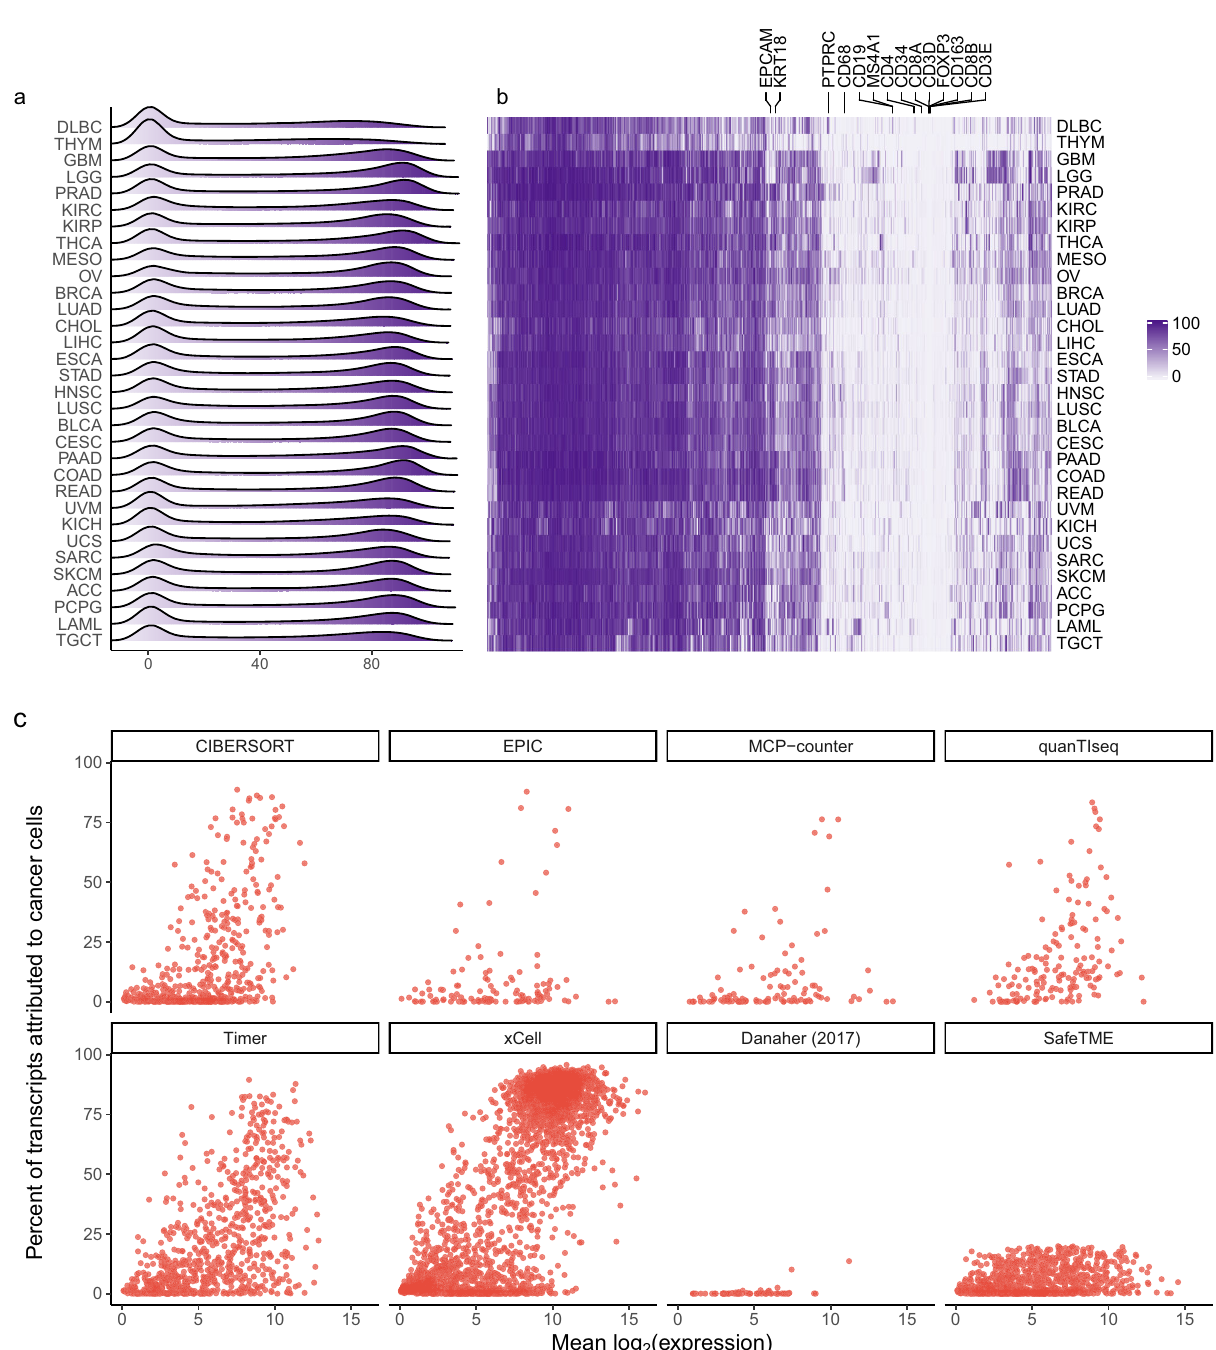
Fig. 3 Genes ’ proportions of cancer cell-derived expression in tumors. a For each cancer type, density of genes ’ percent of transcripts attributed to cancer cells. b For all genes in all cancer types, estimated percent of transcripts attributed to cancer cells. c Averaged across all non-immune tumors, genes ’ mean expression and percent of transcripts attributed to cancer cells. Panels show gene lists from CIBERSORT, EPIC, MCP-counter, quanTIseq, Timer, xCELL, Danaher (2017), and SafeTME, the tumor-immune deconvolution cell pro fi le matrix developed here. Source data are provided as a Source Data fi